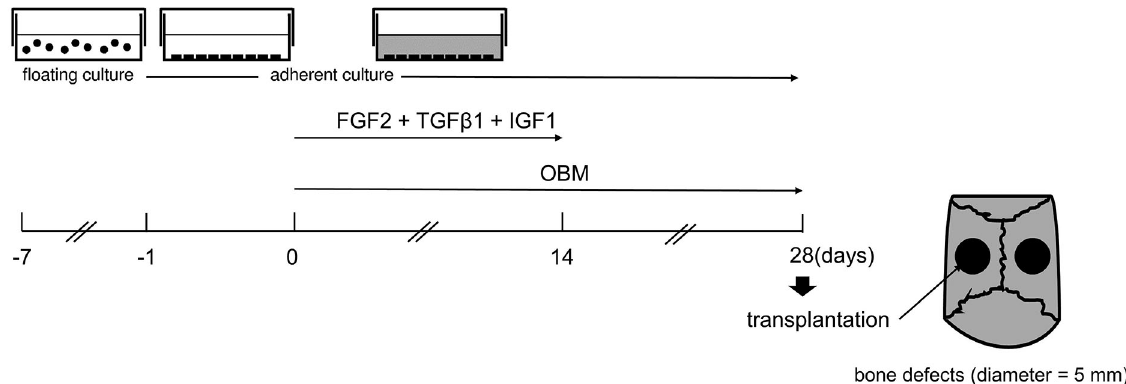
Figure 4- Outline of the protocol for the differentiation of iPSCs into osteoblasts